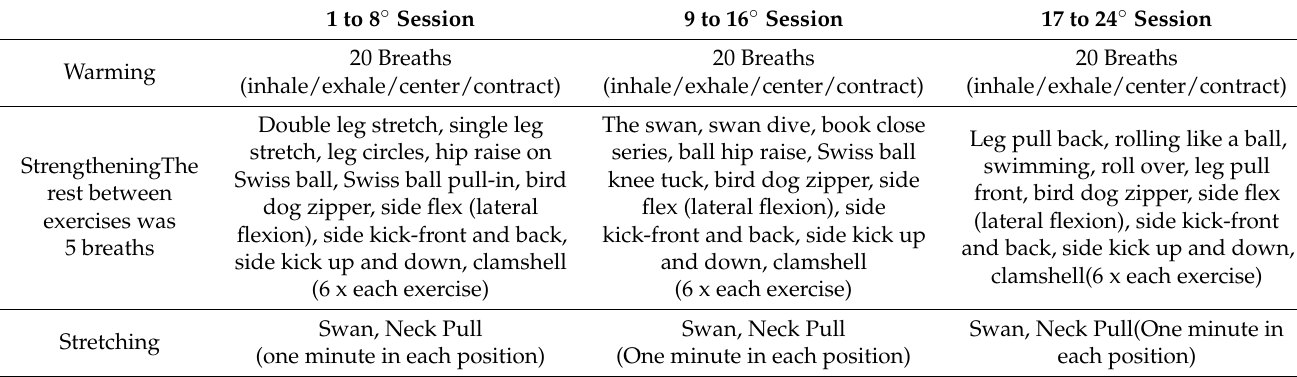
Table 2. Pilates Exercise